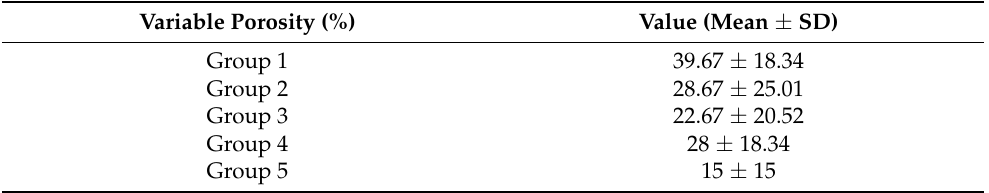
Figure 6. Microstructure and porosity evaluation with scanning electron microscope and ImageJ tools 12 weeks after implantation showed tissue integration with scaffolds: ( 1 – 3 ) Group 1 (auto- graft), ( 4 – 6 ) Group 2 (PLA), ( 7 – 9 ) Group 3 (PLA + HA/alginate), ( 10 – 12 ) Group 4 (PLA + MSc) and ( 13 – 15 ) Group 5 (PLA + HA/alginate + MSc). Table 1. Porosity distribution among groups.